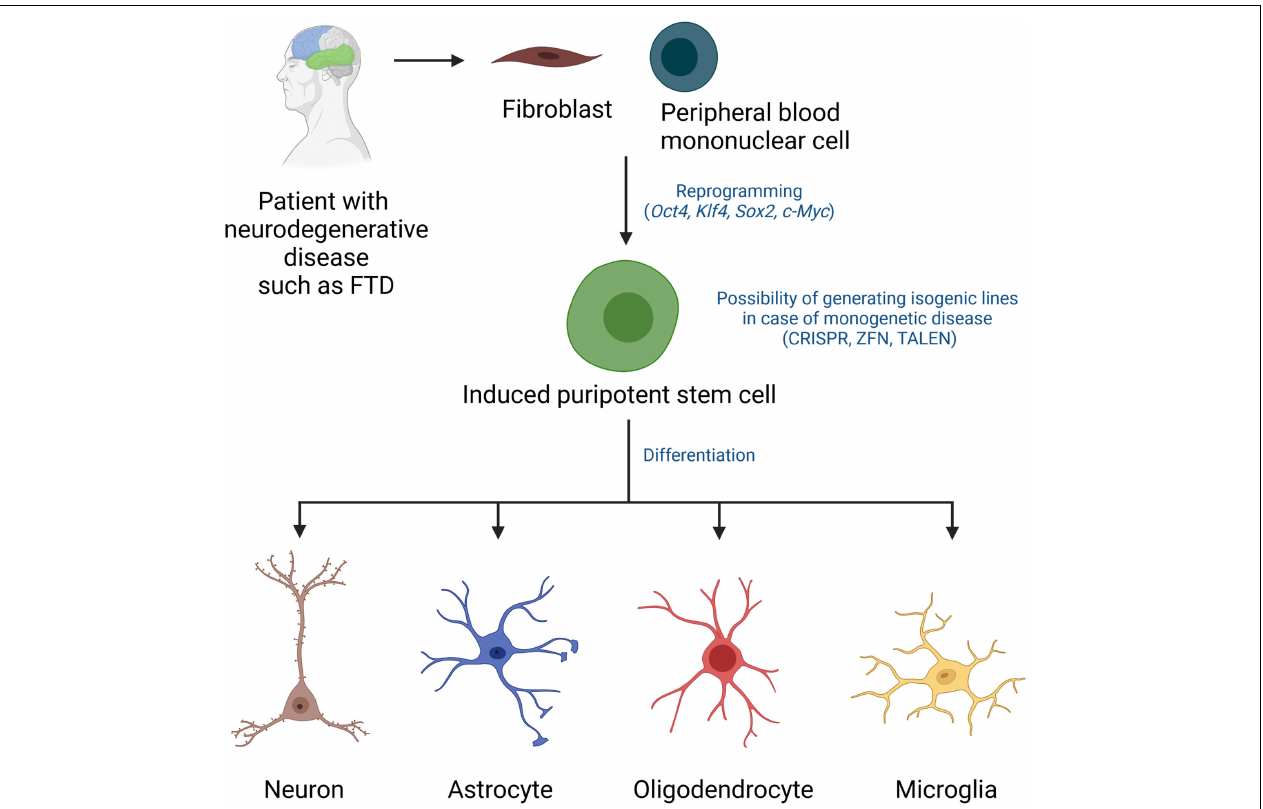
FIGURE 1 | Disease modeling using patient-derived induced pluripotent stem cells. iPSCs can be derived from fibroblasts or peripheral blood mononuclear cells of patients using established reprogramming technologies involving overexpression of the transcription factors Oct4 , Klf4 , Sox2 , c-Myc . Gene editing has been applied in various studies to generate isogenic lines. iPSCs from patients and control cells (isogenic iPSCs or healthy donor-derived iPSCs) can be guided to differentiate into neurons, astrocytes, oligodendrocytes, and microglia using optimized differentiation protocols and they can then be tested in various disease modeling and/or drug screening assays. CRISPR, clustered regularly interspaced short palindromic repeats; ZFN, zinc finger nucleases; TALEN, transcription activator-like effector